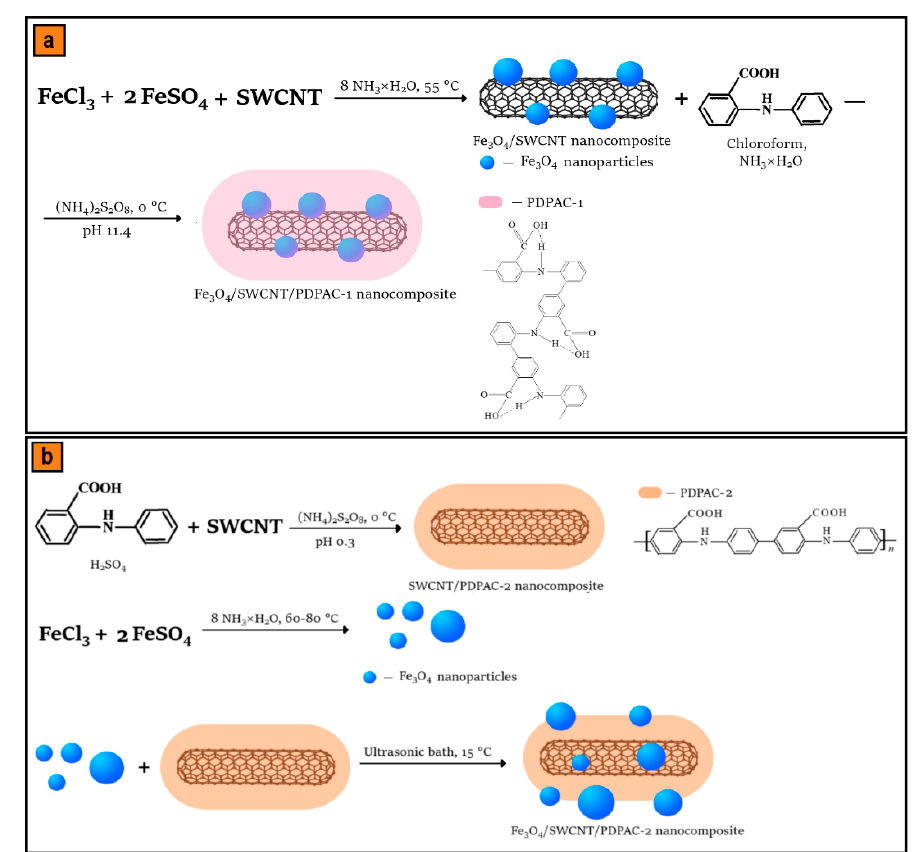
/ SWCNT / PDPAC in alkaline ( a ) and acidic media ( b 3 O 4